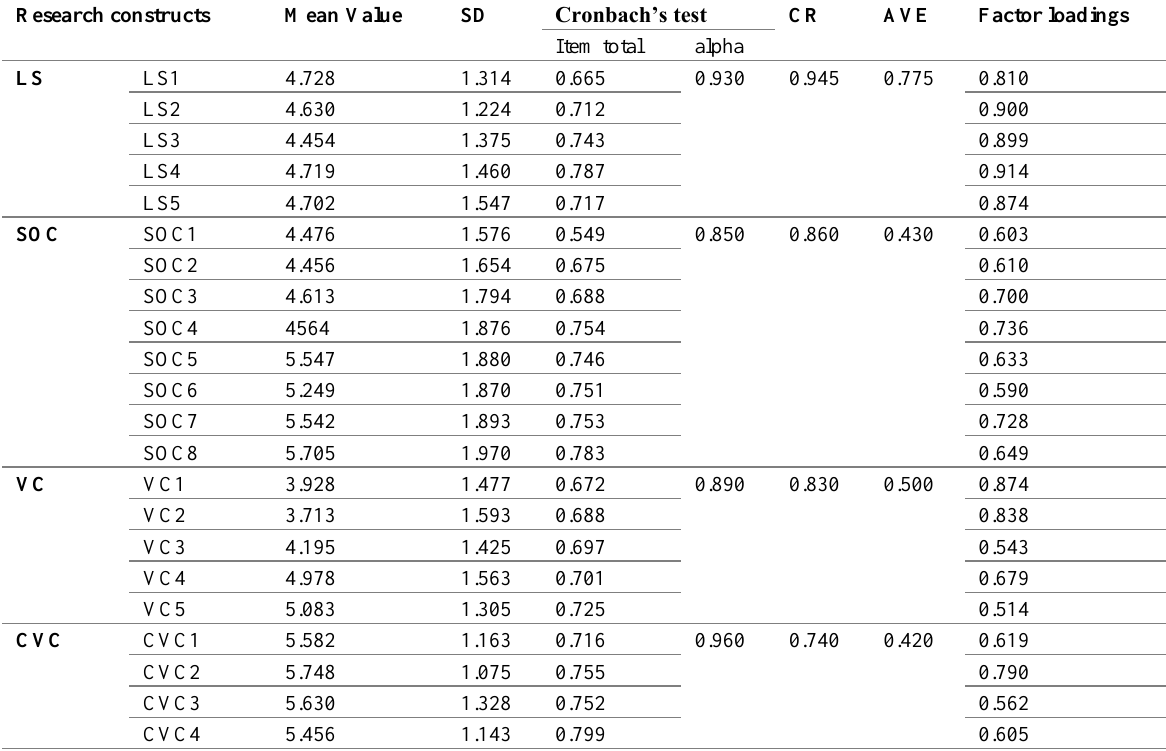
Table 5: Psychometric properties of measurement